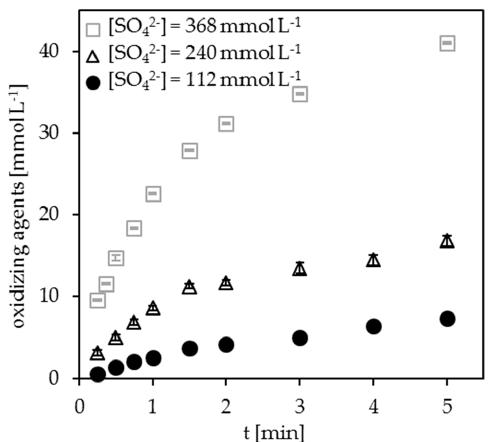
Figure 5. Total oxidizing agent’s concentration as a function of the electrolysis time and sulfate concentration; H 2 SO 4 , pH = 1.4, I = 4.0 A, stainless steel cathode, DiaCCon BDD.